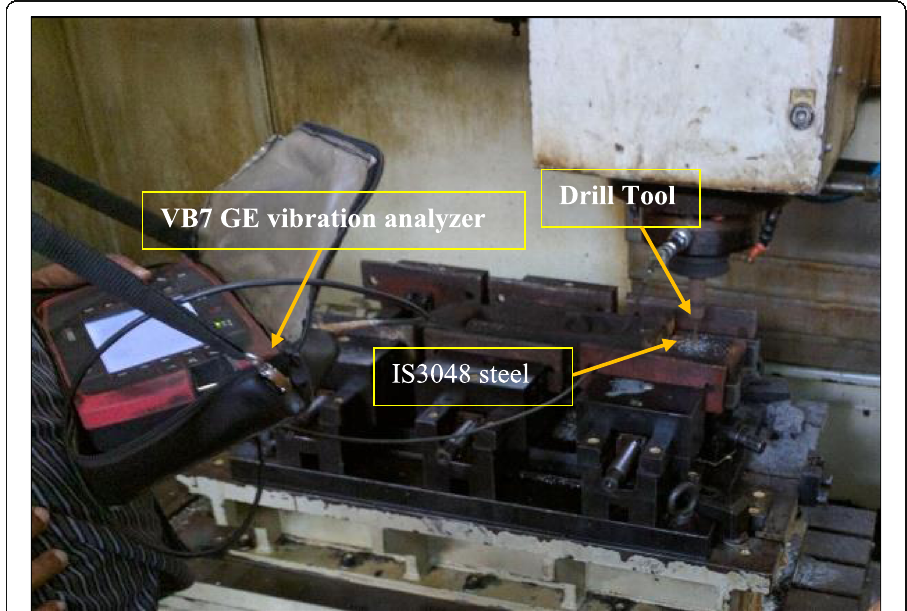
Fig. 1 BFW – BMV 60 CNC vertical machining